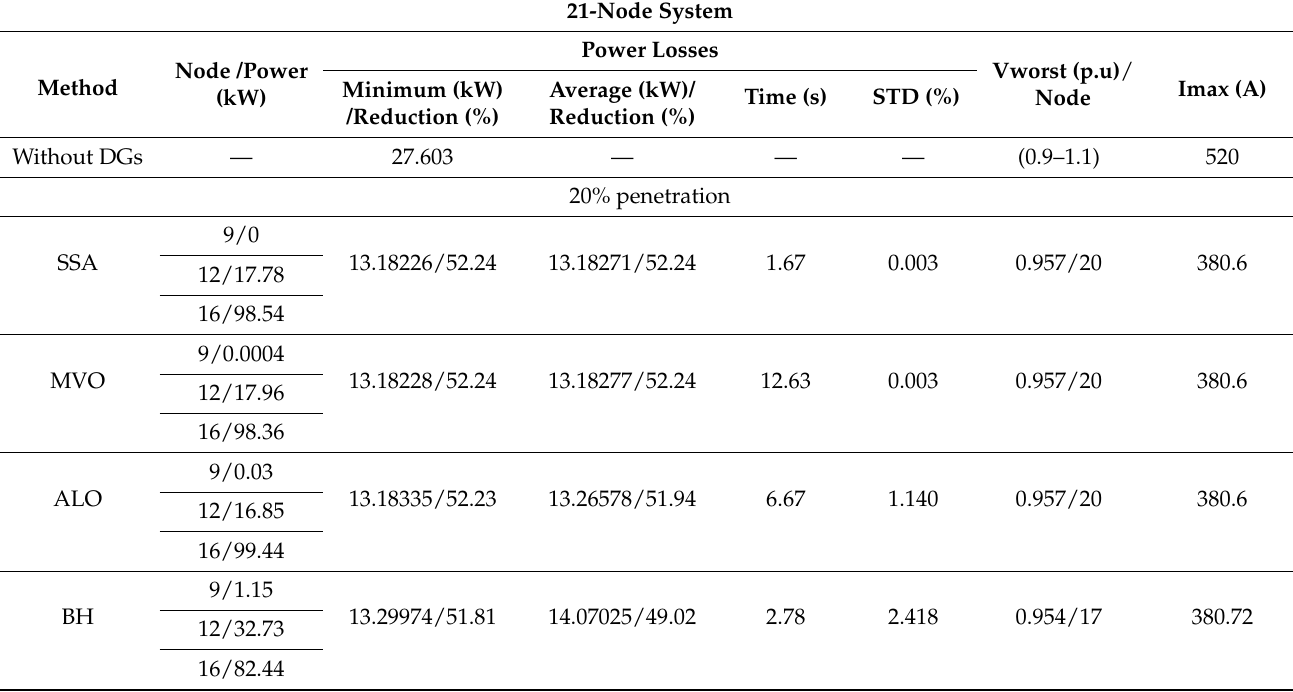
Table 4. Results of the simulations in the 21-node